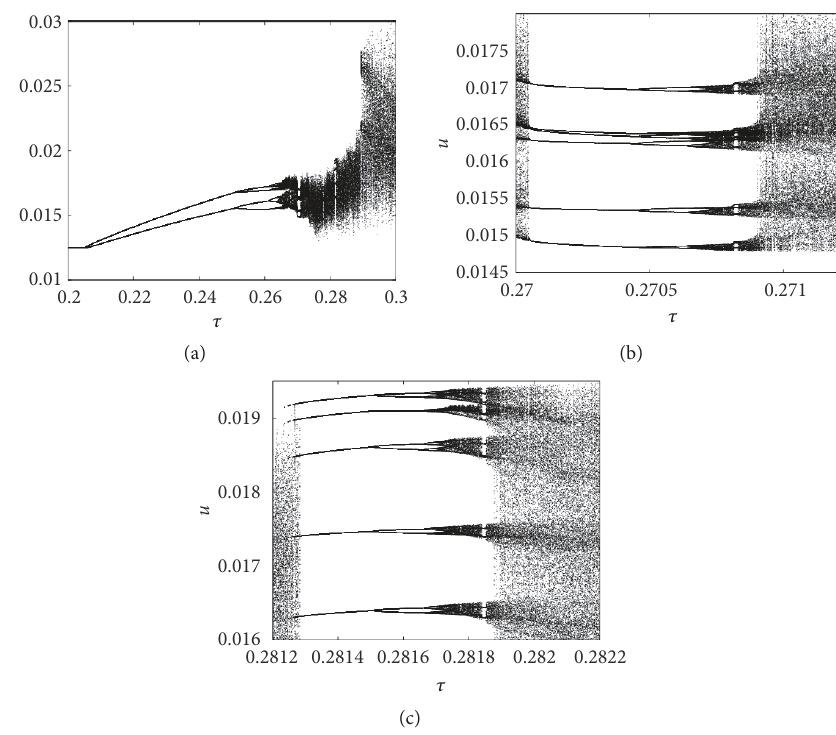
Figure 1: (a) Flip bifurcation diagram of the discrete predator-prey system corresponding to variation of 𝜏 ranging in [0.2,0.3] . 𝑎 = 0.1 , 𝑏 = 0.001 , 𝑐 = 10 , 𝑑 = 0.05 , and 𝑒 = 0.037 . (b) and (c) Local amplifications of (a) in [0.27,0.2712] and [0.2812,0.2822] showing the detail of periodic